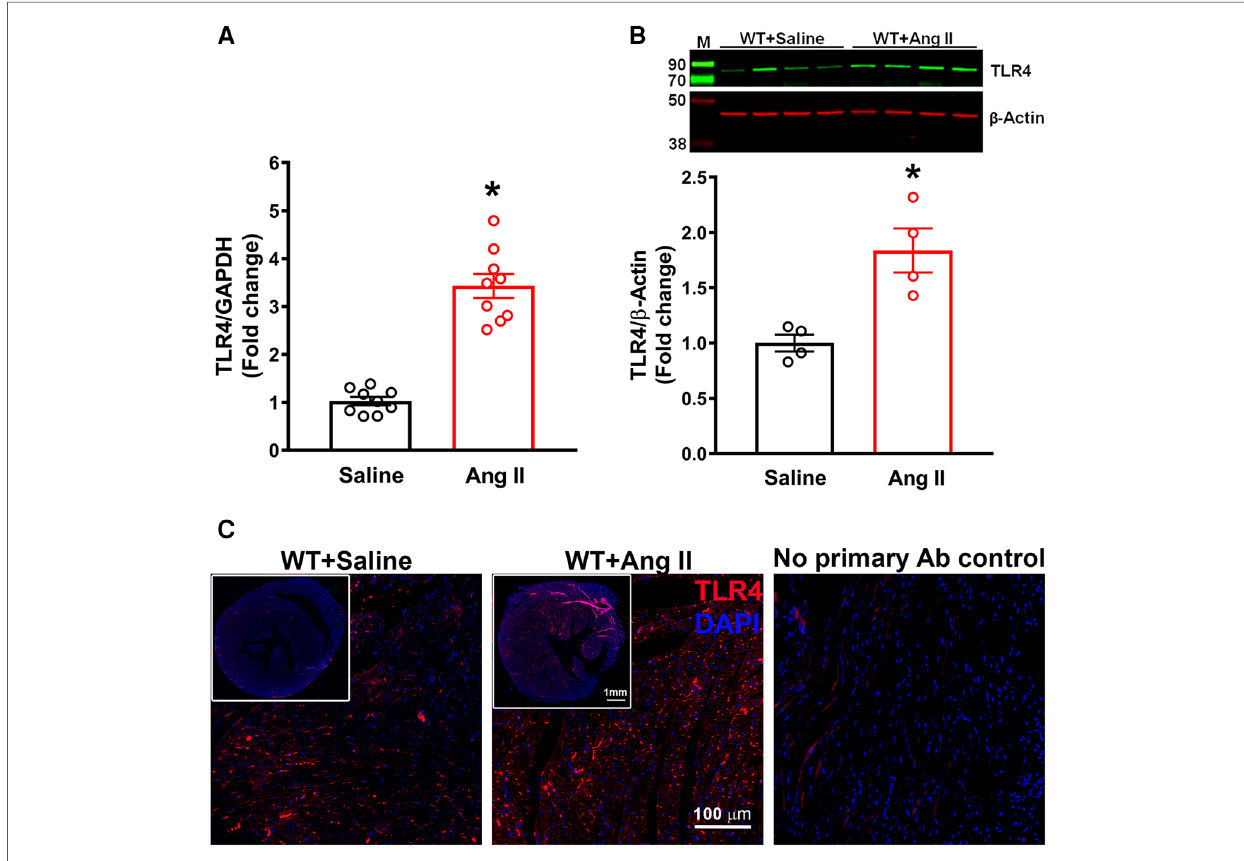
FIGURE 1 Cardiac TLR4 expression is increased in angiotensin II-induced hypertension. ( A ) Gene expression measured by real time RT-PCR shows a signi fi cant increase in cardiac TLR4 mRNA after 14 days of angiotensin (Ang) II treatment ( n =9/group, unpaired, 2-tailed t -test, * p <0.05 vs. saline). ( B ) Representative images from western blot analysis and quanti fi cation reveals an increase in TLR4 protein expression in heart lysates from hypertensive mice ( n =4/group, unpaired, 2-tailed t -test, * p <0.05 vs. saline controls). ( C ) Immuno fl uorescence staining reveals a largely elevated expression of TLR4 (red) in hypertensive mice compared with saline infused